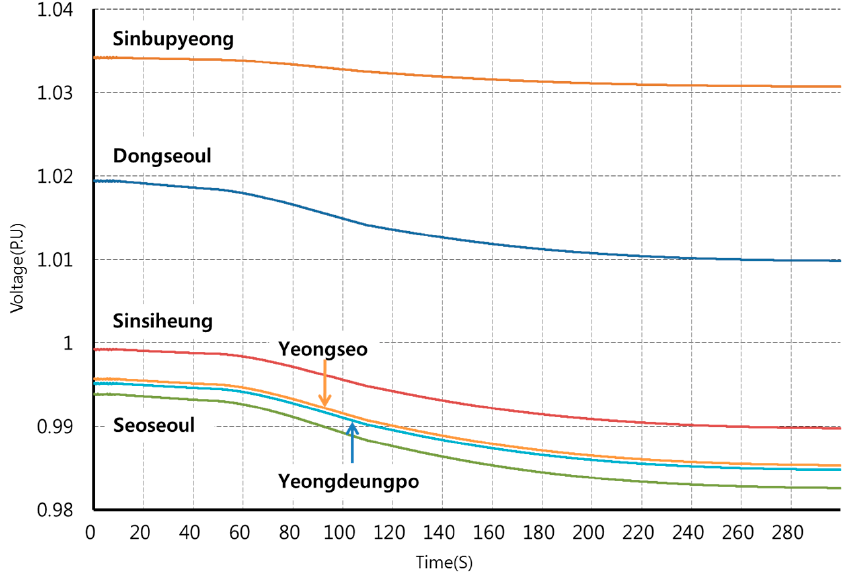
Figure 11. Voltages of pilot points in the metropolitan area.